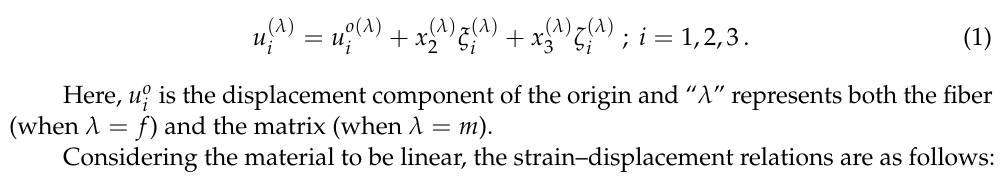
Figure 3. ( a ) A cell of the microstructure. ( b ) The representative unit cell (RUC). The RUC refers to a local coordinate system ( X 1 ,